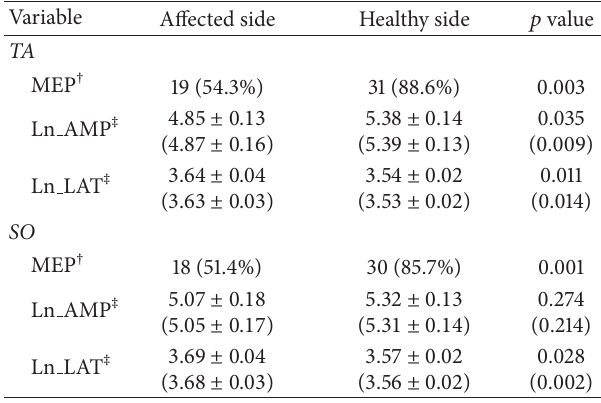
Table 2: TMS parameters on affected and healthy